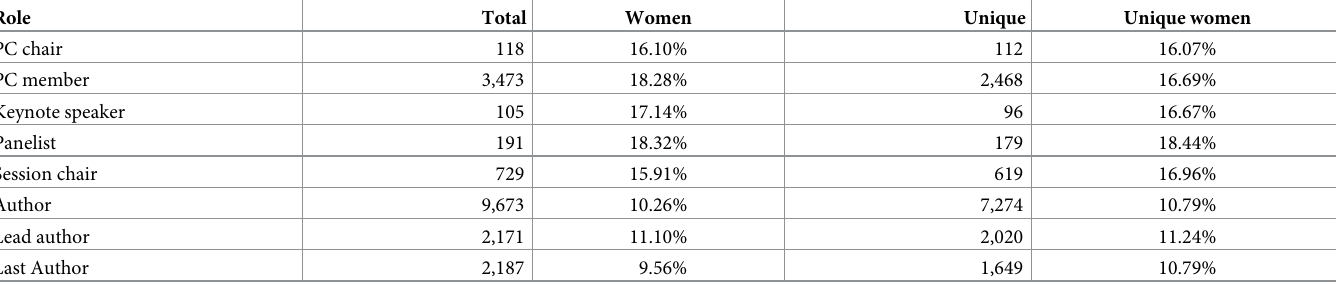
Table 3. Researcher count and ratio of women by role for systems conferences. Researchers are either aggregated by total appearances or identified uniquely, once per role. Lead authors in systems are typically the primary contributor and last authors are typically the senior member of the team.